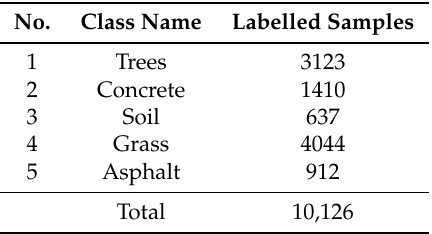
Table 2. Reference classes for the HYDICE Urban data set.